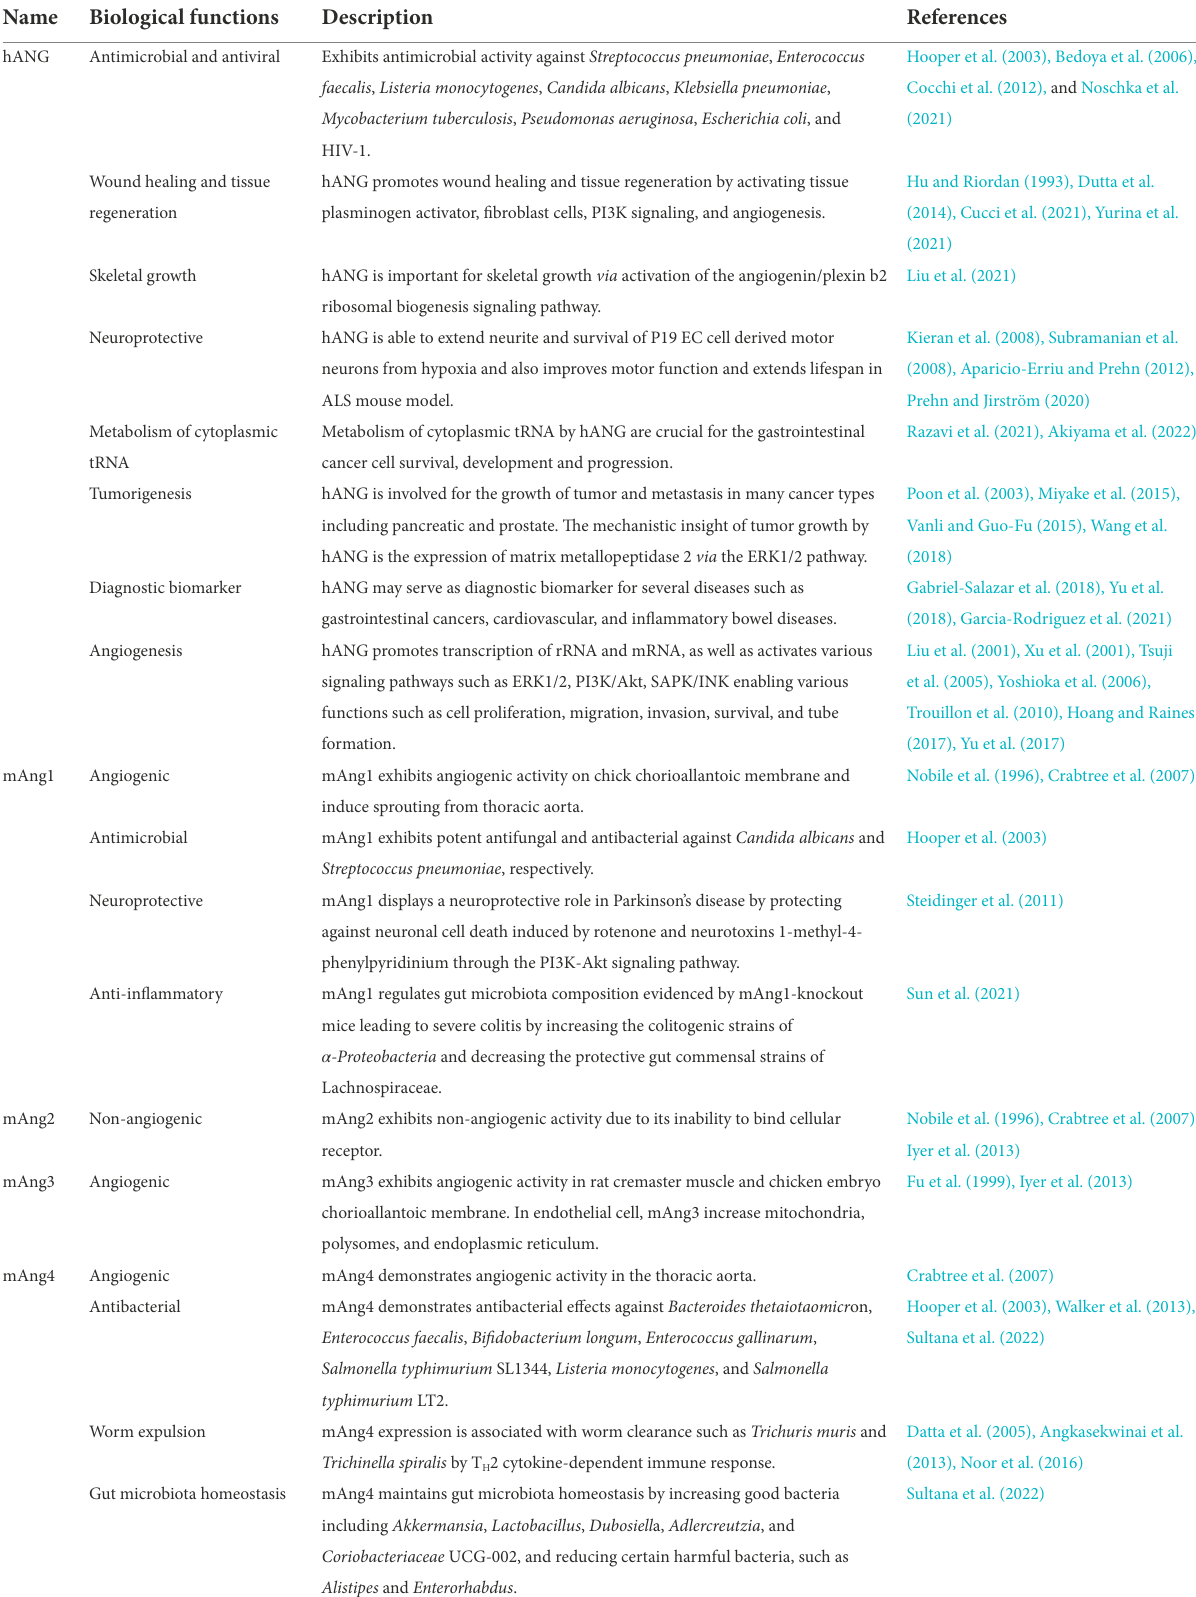
TABLE 1 Summary of biological functions of human and mouse